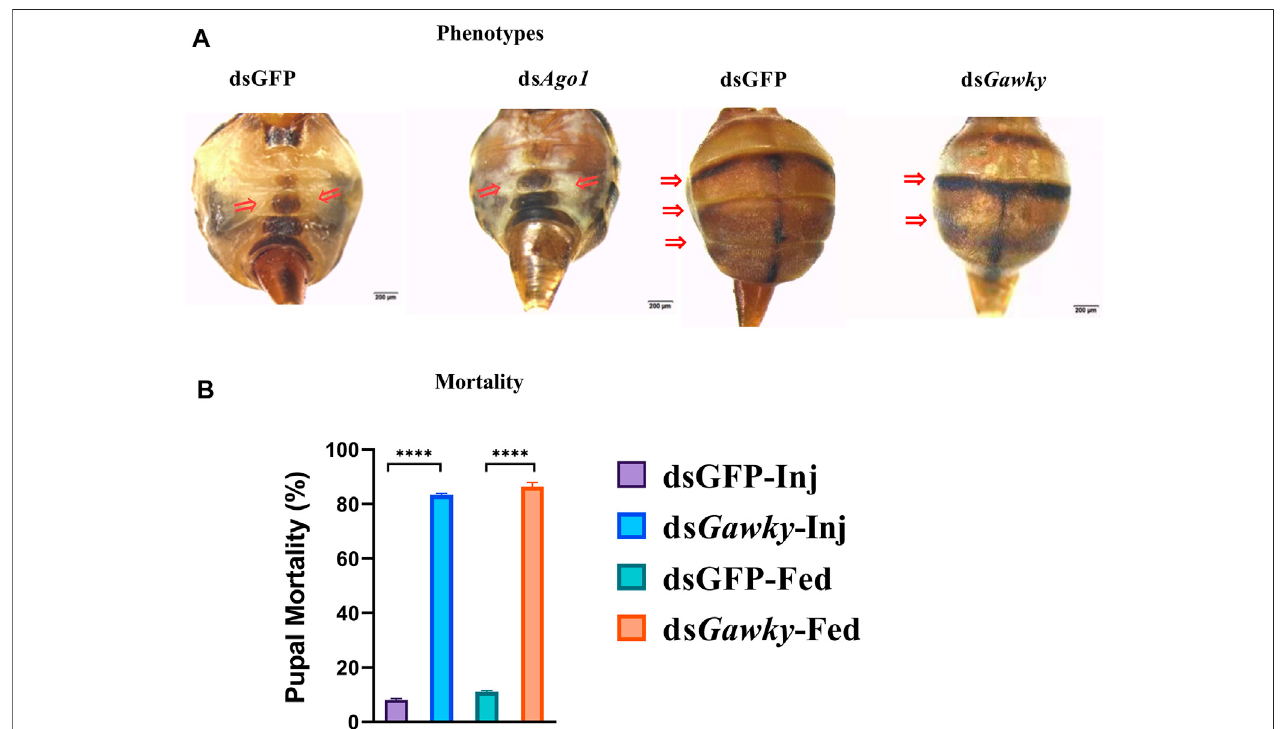
FIGURE 4 | Structural abnormalities and developmental defects after silencing Ago1 and Gawky of Z. cucurbitae . 3 rd instar larvae were fed dsRNA in the arti fi cial diet and eggs 30 m after egg-laying were microinjected with dsRNA. dsGFP was used as a control. (A) Phenotypes of fl ies delivered with dsRNA of Ago1 , Gawky , and GFP.Arrowsrepresentthelossofpigmentationfords Ago1 andthelossofbodysegmentationfords Gawky . (B) Mortality(%)of Z.cucurbitae duetosilencingds Gawky . Thebarsrepresentthemean±SDwiththreebiologicalreplicates.Theasterisksabovethebarsrepresentsigni fi cantdifferencesbetweenthecontrolandtreatment groups (**** p ≤ 0.001). dsGFP-Inj and ds Gawky -Inj represent silencing GFP and Gawky by microinjecting their dsRNAs, respectively. dsGFP-Fed and ds Gawky -fed represent silencing GFP and Gawky by feeding their dsRNAs, respectively.